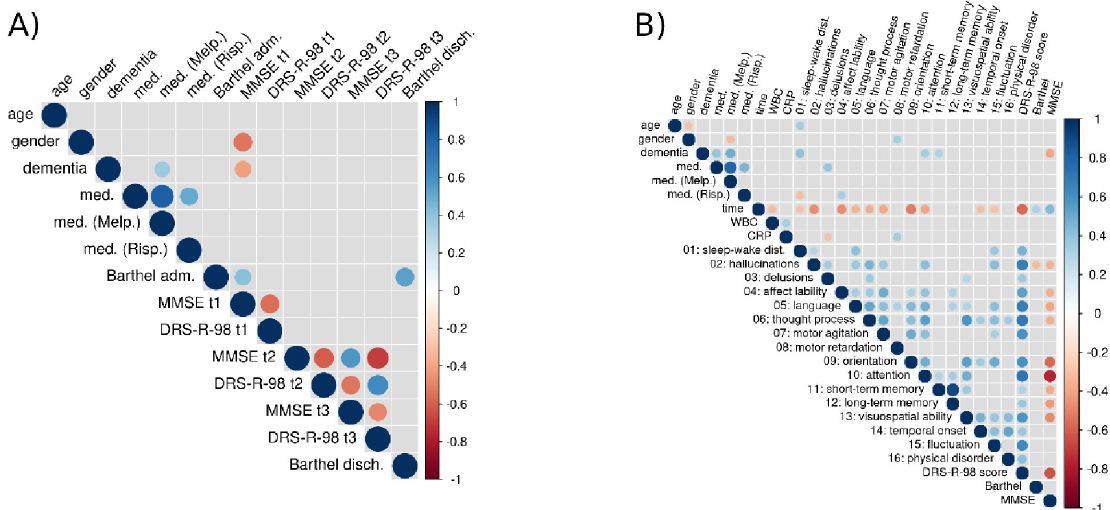
Fig 2. A: Correlation structure of test scores and demographic factors. Only correlations (Spearman) significant at 0.05 are shown. Dot size and color represent magnitude of correlation; darker color depicts stronger correlation. B: Correlation structure of DRS-R-98 symptoms and total score, MMSE score, and laboratory parameters: C-reactive protein and white blood cell count. Barthel adm. = Barthel Index admission, Barthel disch. = Barthel discharge, DRS-R-98 = Delirium Rating Scale Revised 98, MMSE = Mini-Mental Status